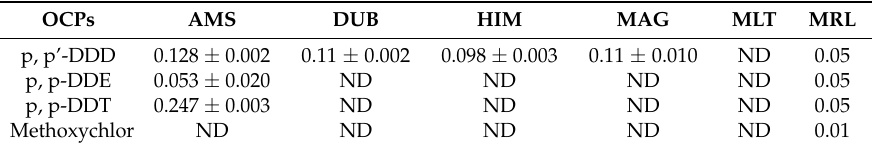
Table 4. Mean concentrations of dichloro diphenylethene (mg/kg) isomers in Malt Drink.